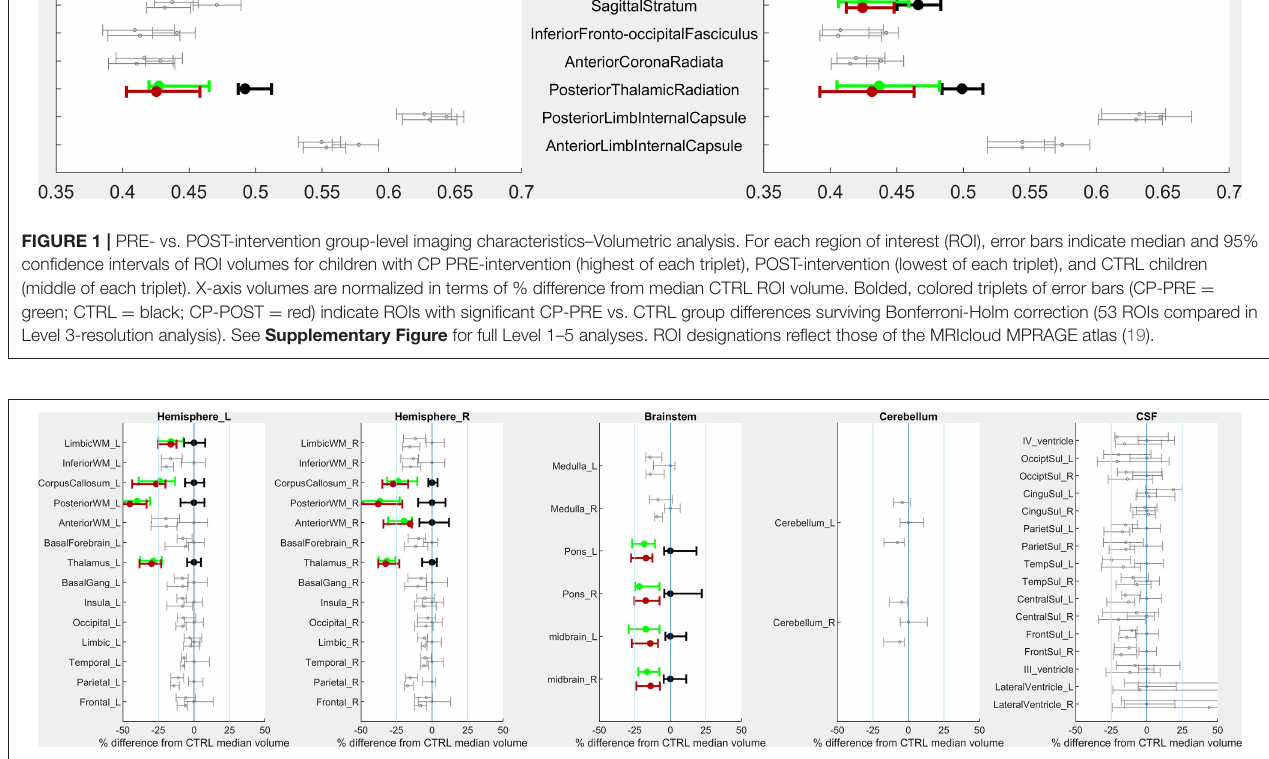
FIGURE 2 | PRE- vs. POST-intervention group-level imaging characteristics–Fractional anisotropy. For each region of interest (ROI), error bars indicate mean and 95% confidence intervals of ROI volumes for children with CP PRE-intervention (highest of each triplet), POST-intervention (lowest of each triplet) and CTRL children (middle of each triplet). The X-axis indicates regional FA. Bolded, colored triplets of error bars (CP-PRE = green; CTRL = black; CP-POST = red) indicate ROIs with significant CP-PRE vs. CTRL group differences surviving Bonferroni-Holm correction (18 ROIs compared).